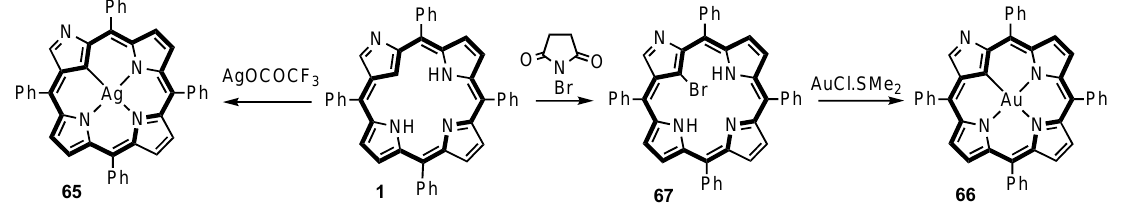
Scheme 14. Synthesis of silver(III) and gold(III) NCPs.